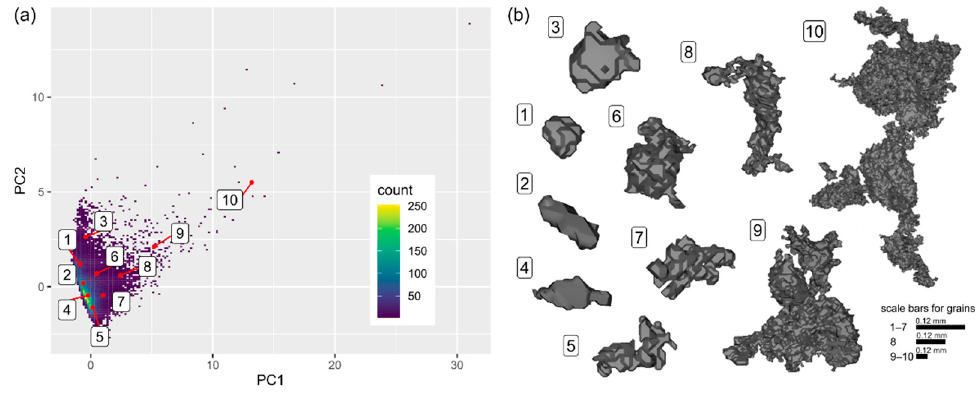
Figure 7. ( a ) Projection of the objects into the PC coordinate system using a density map; ( b ) The visual sample of 10 grains (objects) from the dataset. The labels correspond to these in ( a ).